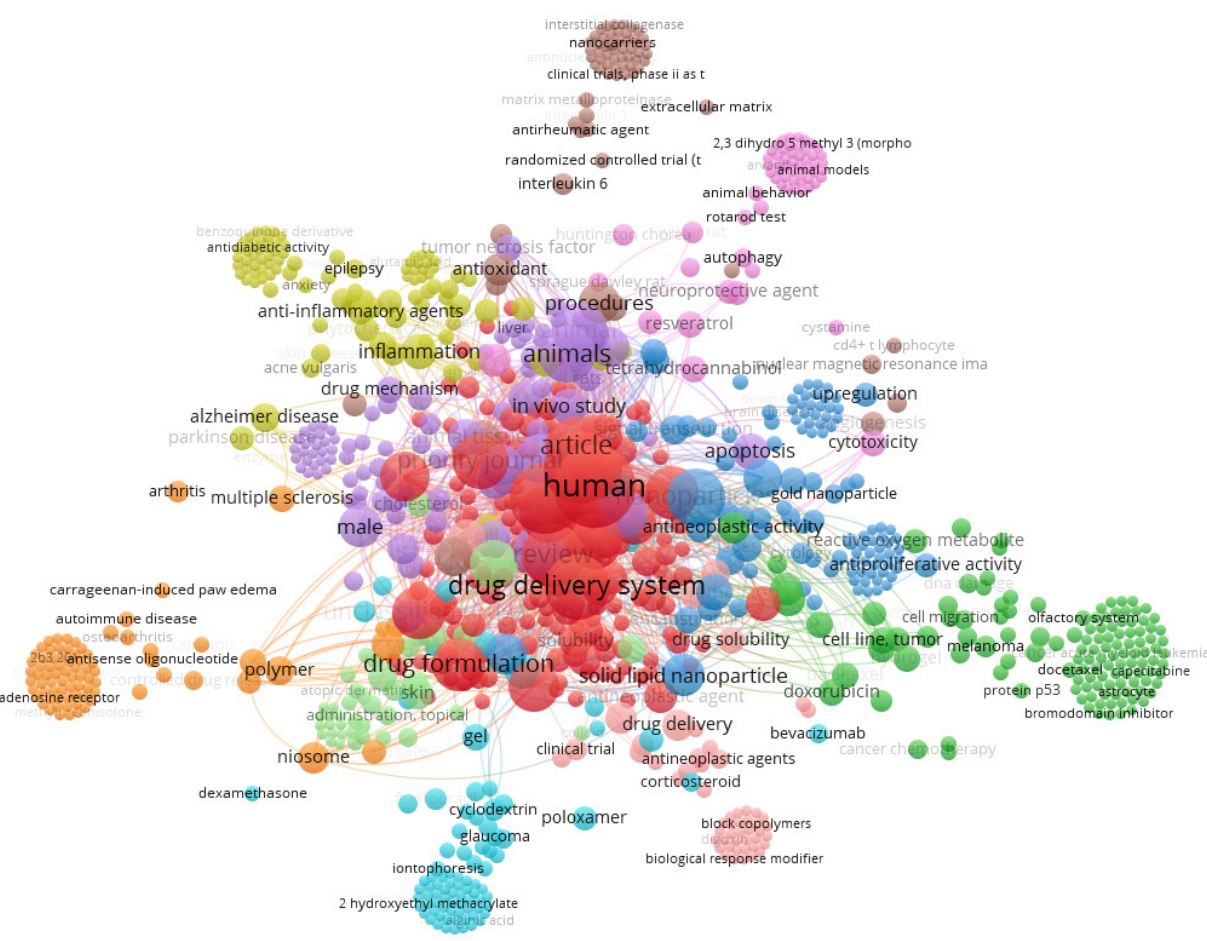
Figure 2. Bibliometric map obtained by VOSviewer software version 1.6.16 using solid lipid nanoparticles and cannabidiol as keywords, from Scopus database [3] .